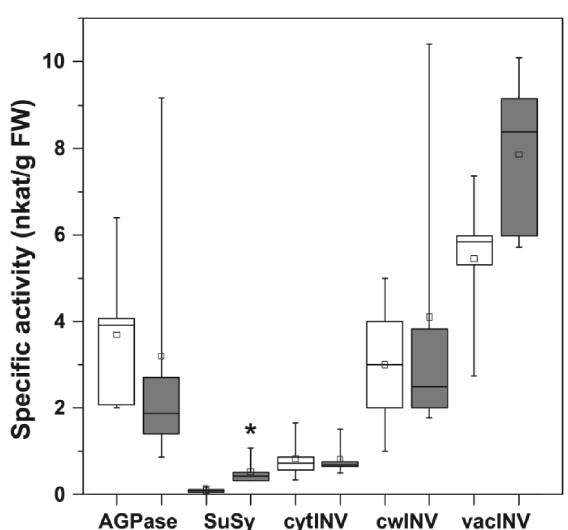
Figure 4. Box plot of the specific activities of AGPase, SuSy, cyt- INV, cwINV and vacINV in fully developed whole-leaf samples of uninfected (white boxes) and š Ca . P. solani’-infected (grey boxes) grapevines. Line across the box, median; square, mean of five bio- logical replicates; box, 25 th and 75 th percentiles; whiskers, mini- mum and maximum values. *, p <0.05 (Student’s t